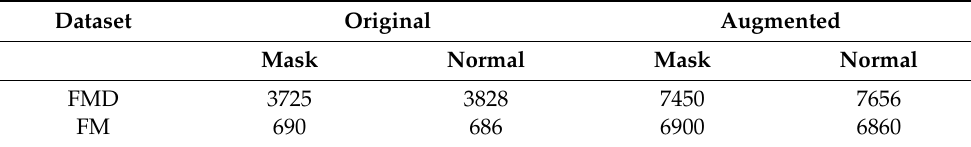
Table 4. The number of samples in the original and augmented